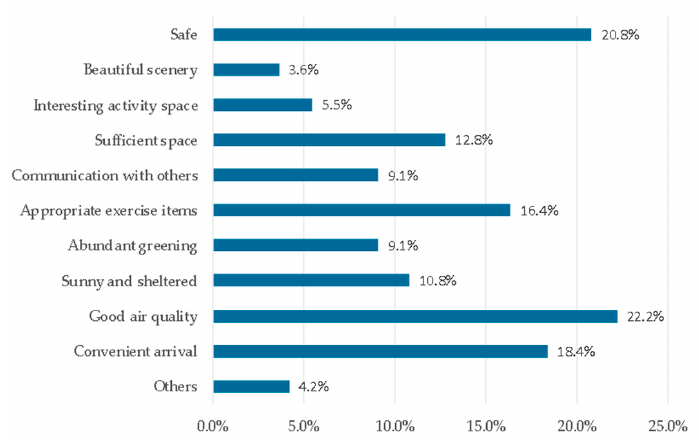
Figure 3. Factors hindering consistent exercise in the green spaces.